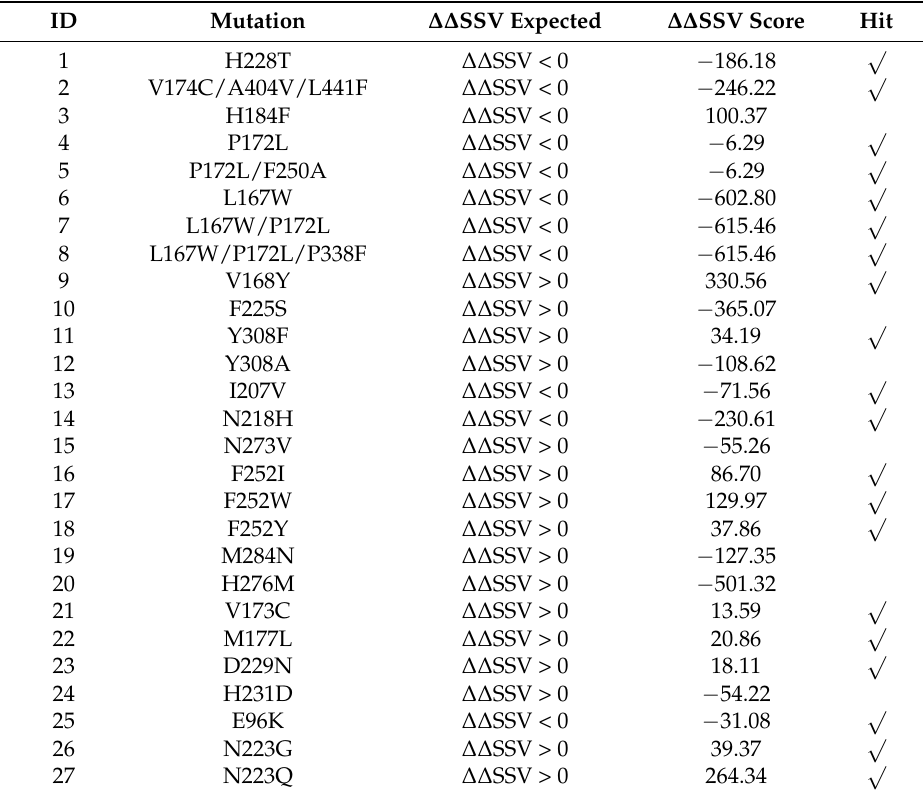
Table 2. ∆∆ SSV score expected and the value predicted by SSV.